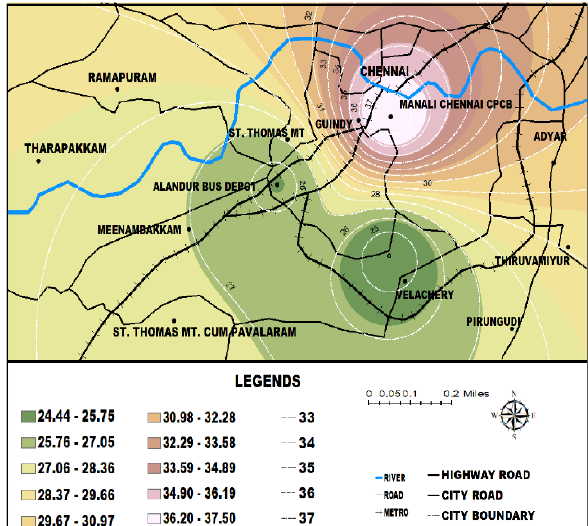
Figure 13. Air quality map of Chennai May monthly average based on PM2.5 (µg/m 3 ).